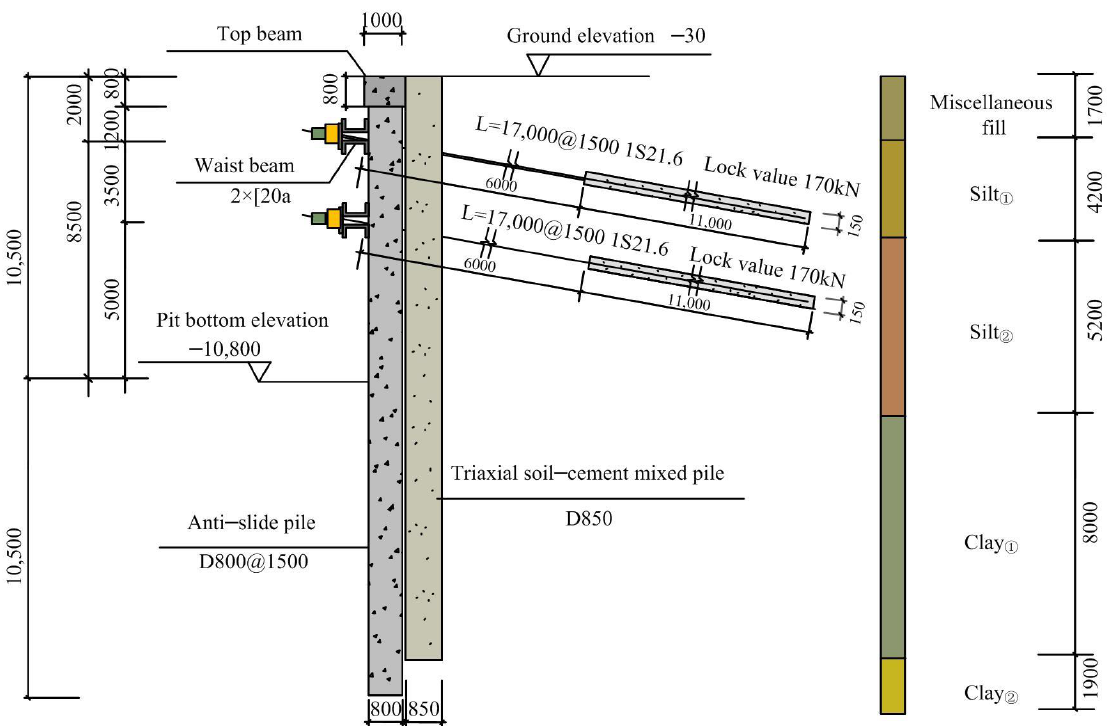
Figure 9. Schematic diagram of the pile – anchor support.